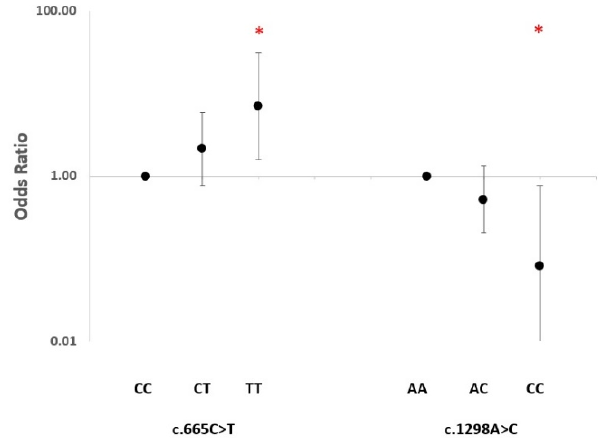
Figure 1. Odds ratio of association of MTHFR c.665C>T and c.1298A>C genotypes with response to anti-TNF-α therapy (GR+MR vs. NR) under a co-dominant model and considering wild-type homozygotes as a reference. * Significant nominal p -value.